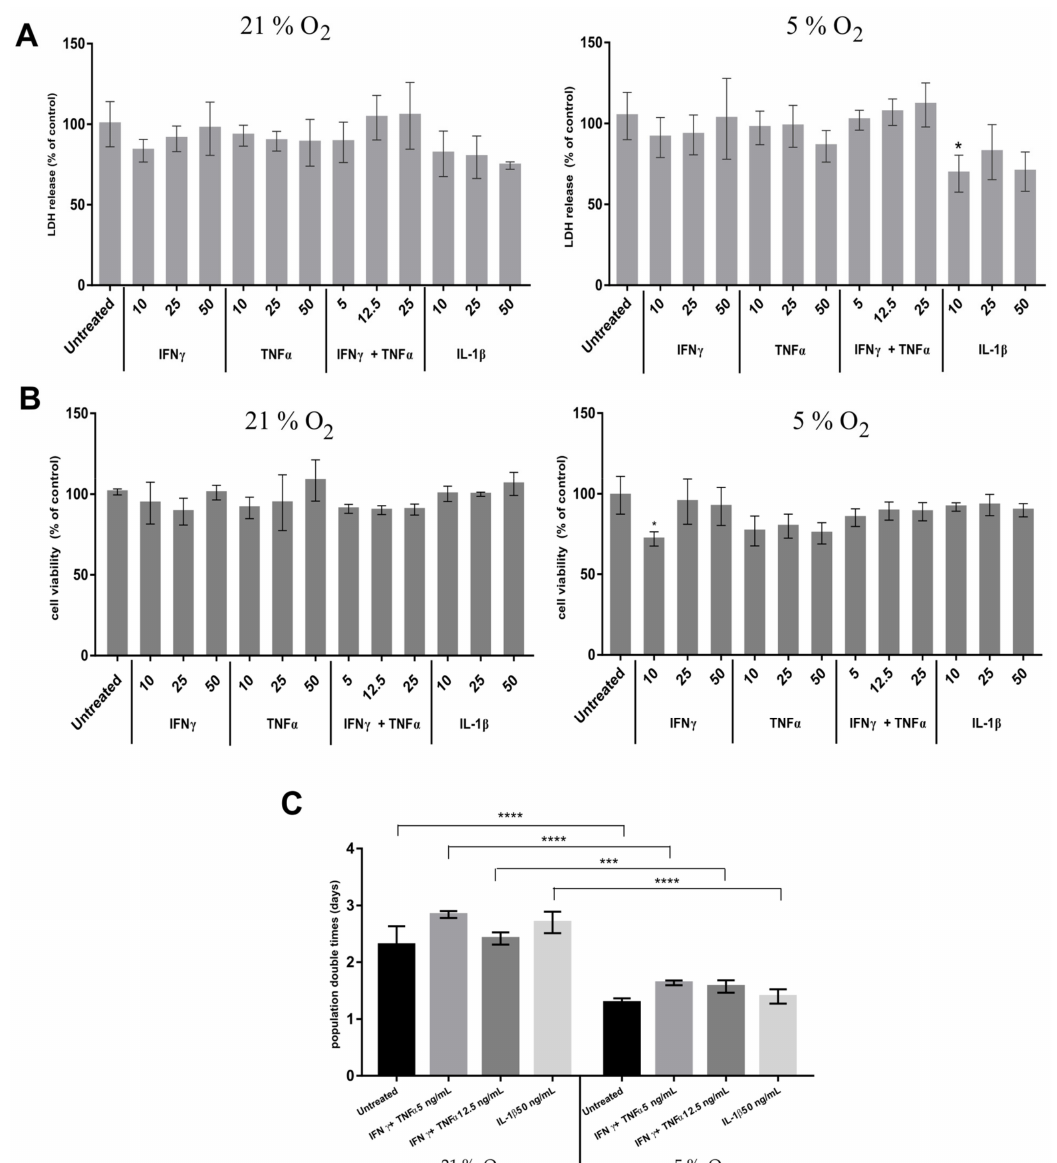
Figure 4. ( A )—Results for WJ-MSC cell-membrane integrity analysis after treatment with proinflammatory cytokines in 21% or 5% O 2 concentrations. There is no increase in LDH secretion into the medium by IFN γ and TNF α -treated cells, as well as a slight reduction in LDH secretion into the medium following IL-1 β treatment in both aerobic variants. * p < 0.1 ( B )—WJ-MSC viability analysis after treatment with proinflammatory cytokines. No significant differences in cell viability. ( C )—Comparison of the WJ-MSC (21% O 2 ) and WJ-MSC (5% O 2 ) population doubling times. The results are mean values (one-way ANOVA) from 3 experiments ± SD; *** p < 0.001, **** p <